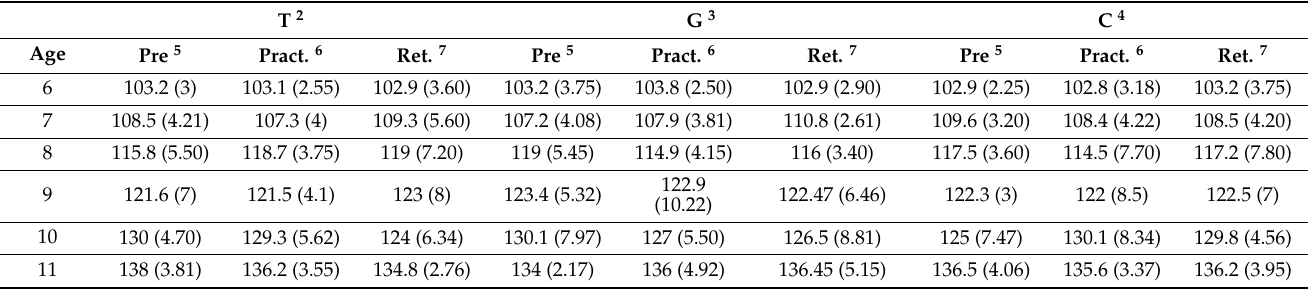
Table 7. SLJ performance scores 1 per age, group, and experimental phase.